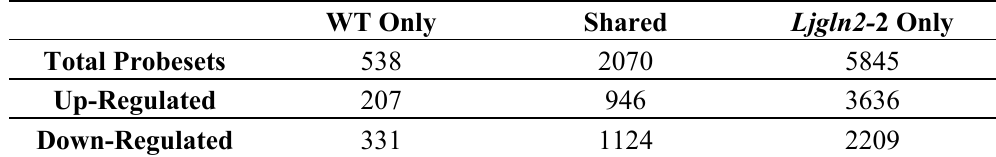
Table 4. Probesets elicited by 4 days of water deprivation in the leaf transcriptomics for either WT or Ljgln2-2 mutant plants.